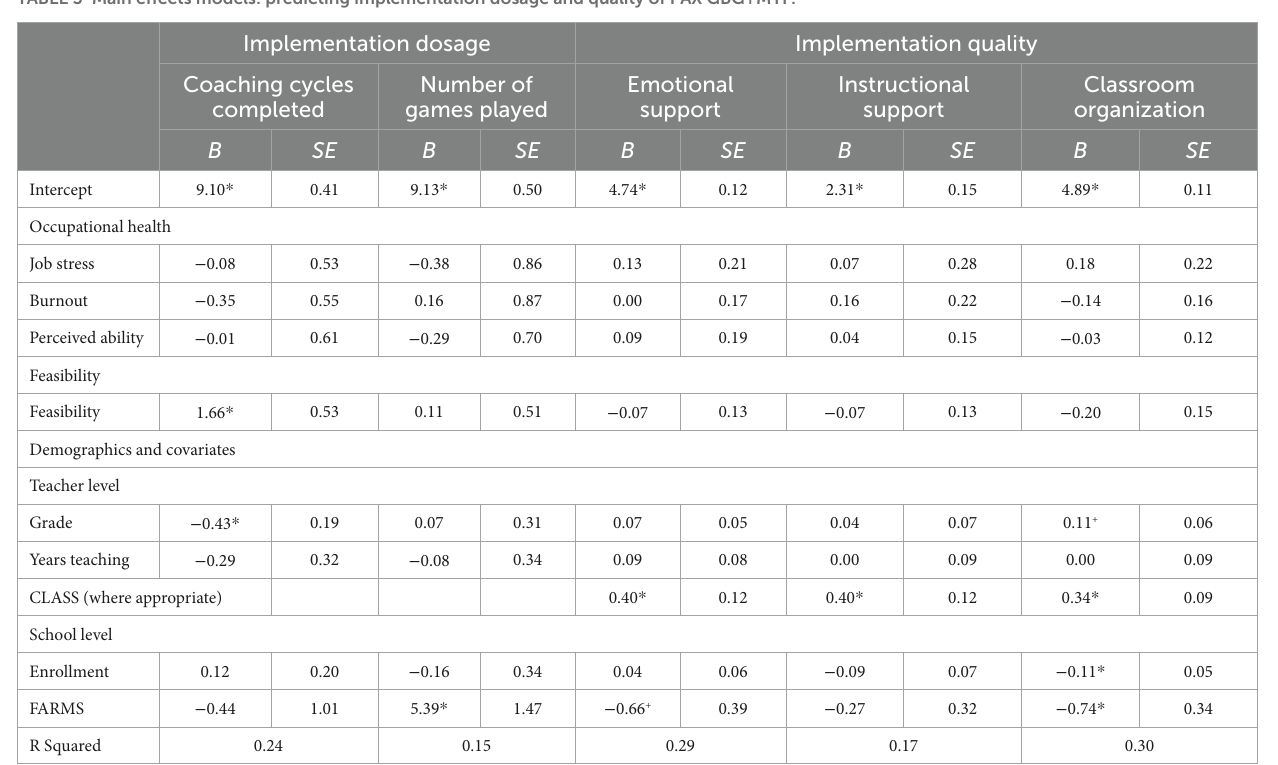
TABLE 3 Main effects models: predicting implementation dosage and quality of PAX GBG + MTP.